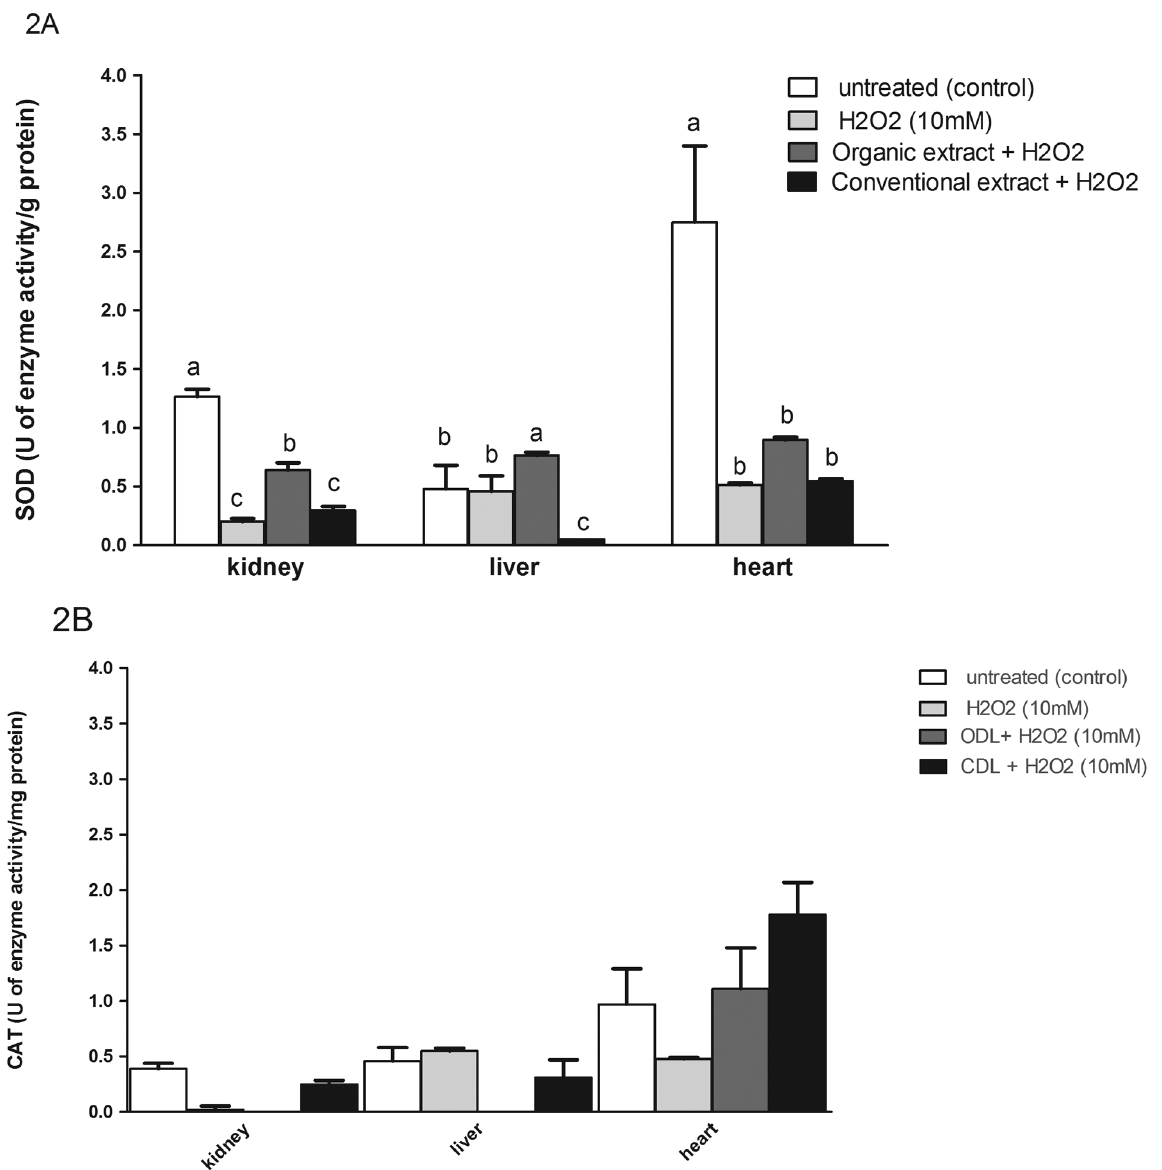
Fig. 2 – SOD (A) and CAT (B) activities in kidney, liver and heart tissues of Wistar rats treated with organic and conventional grape leaf extracts. Data are mean ± SD values of two independent experiments. *Different letters indicate a significant difference; for example, a is different from b according to the analysis of variance and Tukey’s post-hoc test (p = 0 . 05) for each tissue